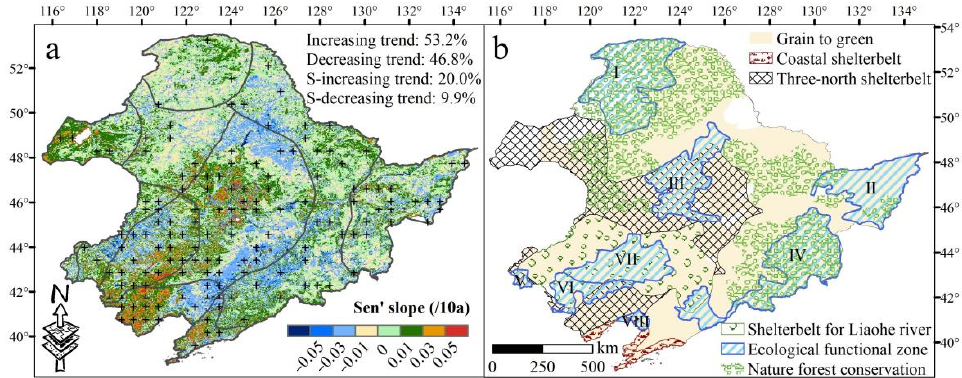
Figure 4. Spatial changes in trending of observed NDVI ( NDVI obs , ( a )), and spatial distribution of ecological restoration projects ( b ) in Northeast China (NEC). S- in ( a ) is the abbreviation of significant. Black crosses indicate significant trends with p < 0.05. The ecological functional zone in ( b ) includes Grater Khingan Mountain- (I), Sanjiang Plain Wetland -(II), Songnen Plain Wetland- (III), Changbai Mountain- (IV), Hunshandake Sandy Land-(V), West Liaohe- (VI), Horqin Sandy Land- (VII), Liaohe River delta wetland- (VIII) Ecological Function zone.